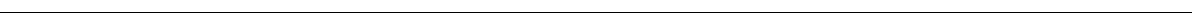
Fig. 5 Dermal-derived Sfrp1 and Igfbp2 proteins induce the emergence of IFE Tbx3 + basal cells. a Immuno fl uoresence of α -SMA ( green ), vimentin ( red ) and Hoechst ( blue ) on ventral skin from virgin and 16 dpc mice. b Quanti fi cation of α -SMA + cells in the vimentin + cell population in the dermis. c , e FISH analysis of Sfrp1 and Igfbp2 mRNAs with anti-sense probes ( green ) in combination with immuno fl uoresence of α -SMA ( magenta ), vimentin ( red ) and Hoechst ( blue ) on ventral skin from 16 dpc mice. d , f Quanti fi cation of Sfrp1 + ( d ) or Igfbp2 + ( f ) cells in the α -SMA + /vimentin + or α -SMA − /vimentin + cell populations in the dermis. g – j Quanti fi cation of Ki67 + ( g , i ) and Tbx3 + ( h , j ) cells in IFE basal layers of ventral skin from 16 dpc mice ( g , h ) and virgin mice ( i , j ) injected with PBS, IWP2, Sfrp1 or Igfbp2. k , l Quanti fi cation of Ki67 + and Tbx3 + cells in IFE basal layers of ventral skin from 16 dpc mice injected with PBS, WAY316606-h or NBI31772. m , n Quanti fi cation of Ki67 + ( m ) and Tbx3 + ( n ) cells in basal layers of ventral skin from 16 dpc wild-type mice and 16 dpc Sfrp1 − / − mice interbred with wild-type males. o , p Quanti fi cation of the division pattern of Axin2-Cre-ER-labelled IFE basal cells ( o ) and K14-Cre-ER-labelled IFE basal cells ( p ) in ventral skin from virgin mice injected with PBS, IWP2, Sfrp1, Igfbp2 or Sfrp1 + Igfbp2. b , d , f – p Data represent the mean ± s.e.m. of averages of three independent experiments ( n = 3). > 100 cells ( b ), > 140 cells ( d ), > 150 cells ( f ), > 500 cells ( g – n ), > 50 cells ( o , p ) were analysed to calculate the average in each experiment; * P < 0.05, ** P < 0.01, *** P < 0.001, analysed by Dunnett ’ s multiple comparison test ( b , g – l ), the two-tailed t -test ( d , f , m , n ) or Tukey ’ s multiple comparison test ( o , p ). a , c , e White-dotted lines represent basement membranes. Experiments were repeated three